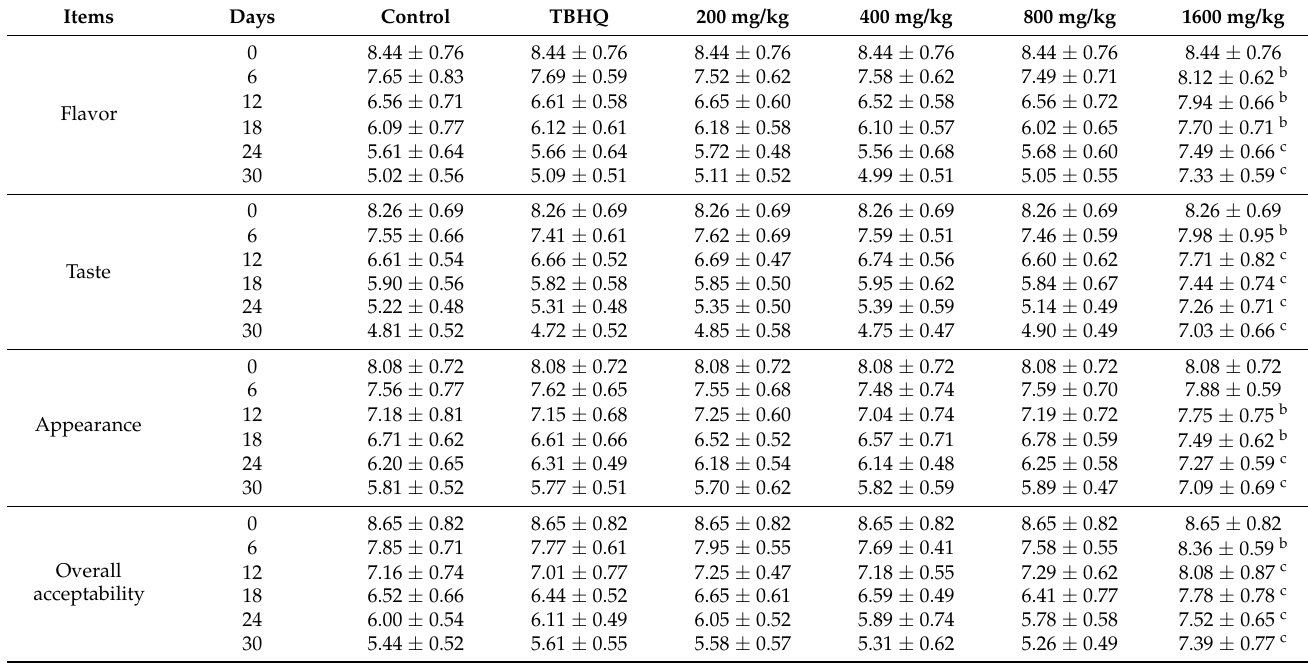
Table 4. The influences of HCEO on flavor, taste, appearance and overall acceptability of sunflower oil.